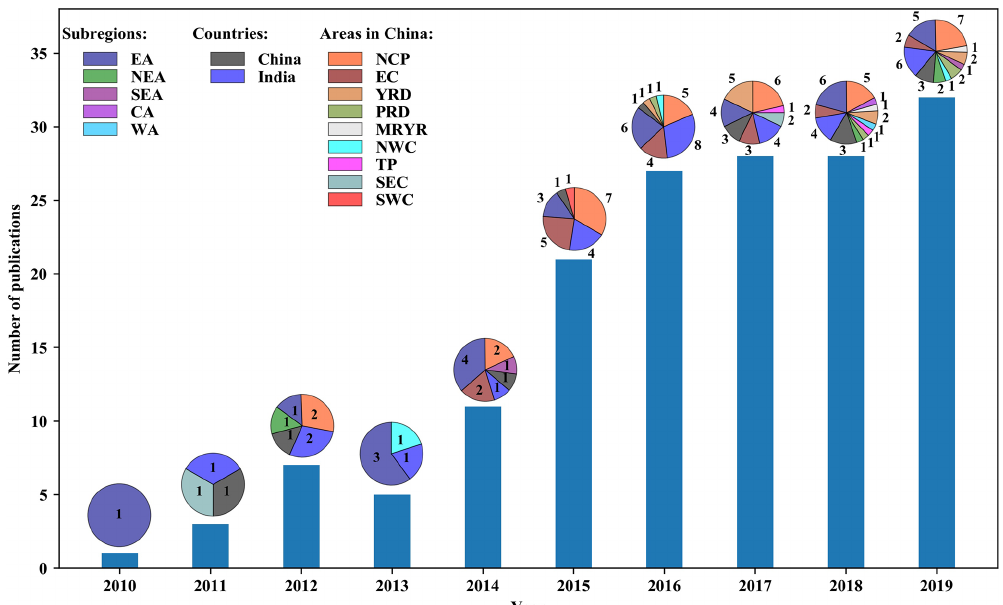
Figure 2. The temporal variations of study activities adopting two-way coupled models in Asia during 2010–2019. (EA: East Asia, NEA: northeastern Asia, SEA: Southeast Asia, EC: eastern China, NCP: North China Plain, YRD: Yangtze River Delta, SEC: southeastern China, NWC: northwestern China, TP: Tibetan Plateau, MRYR: middle reaches of the Yangtze River, SWC: southwestern China; PRD: Pearl River